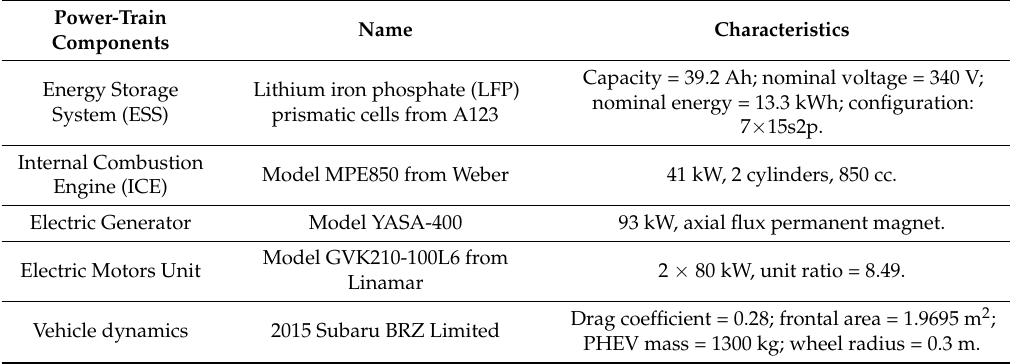
Figure 2. Series PHEV block diagram of the Subaru BRZ 2015 Urban Dynamometer Driving Schedule (UDDS). Table 1. Specification of power-train components of the plug-in hybrid electric vehicle (PHEV).